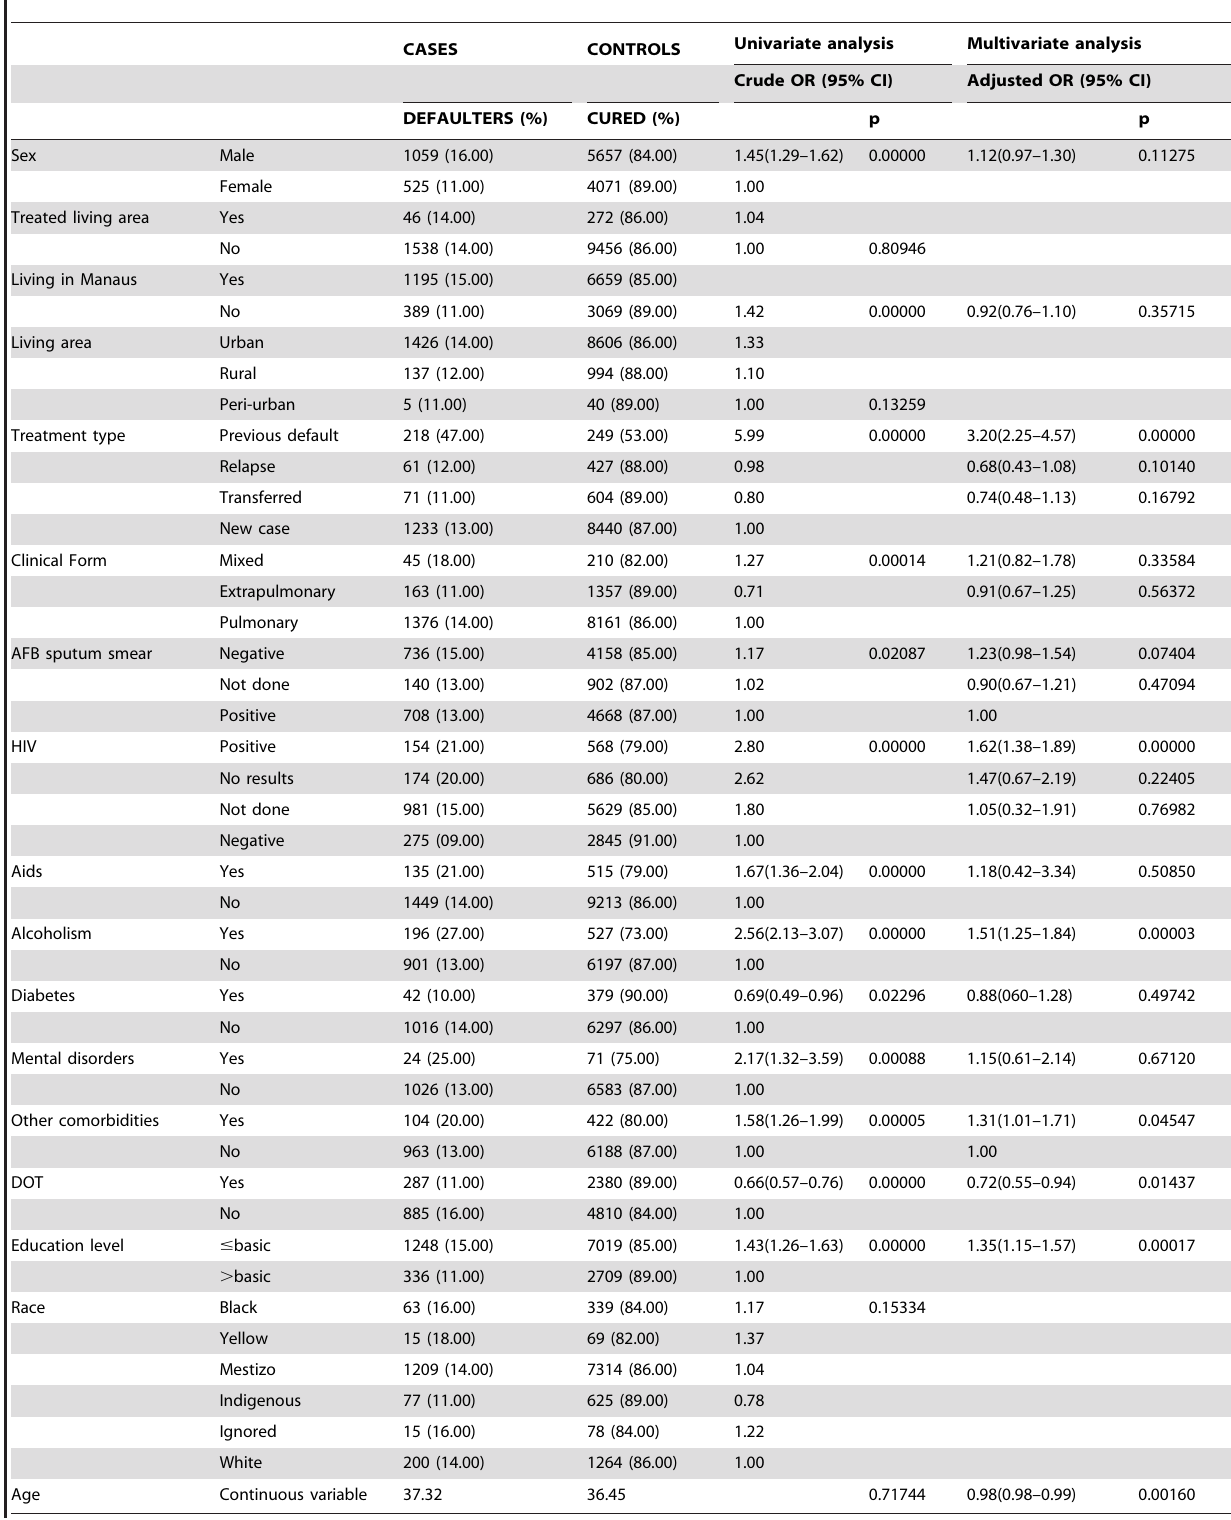
Table 2. Univariate and Multivariate logistic regression analysis of factors independently associated with treatment default for tuberculosis patients from Amazonas State, Brazil